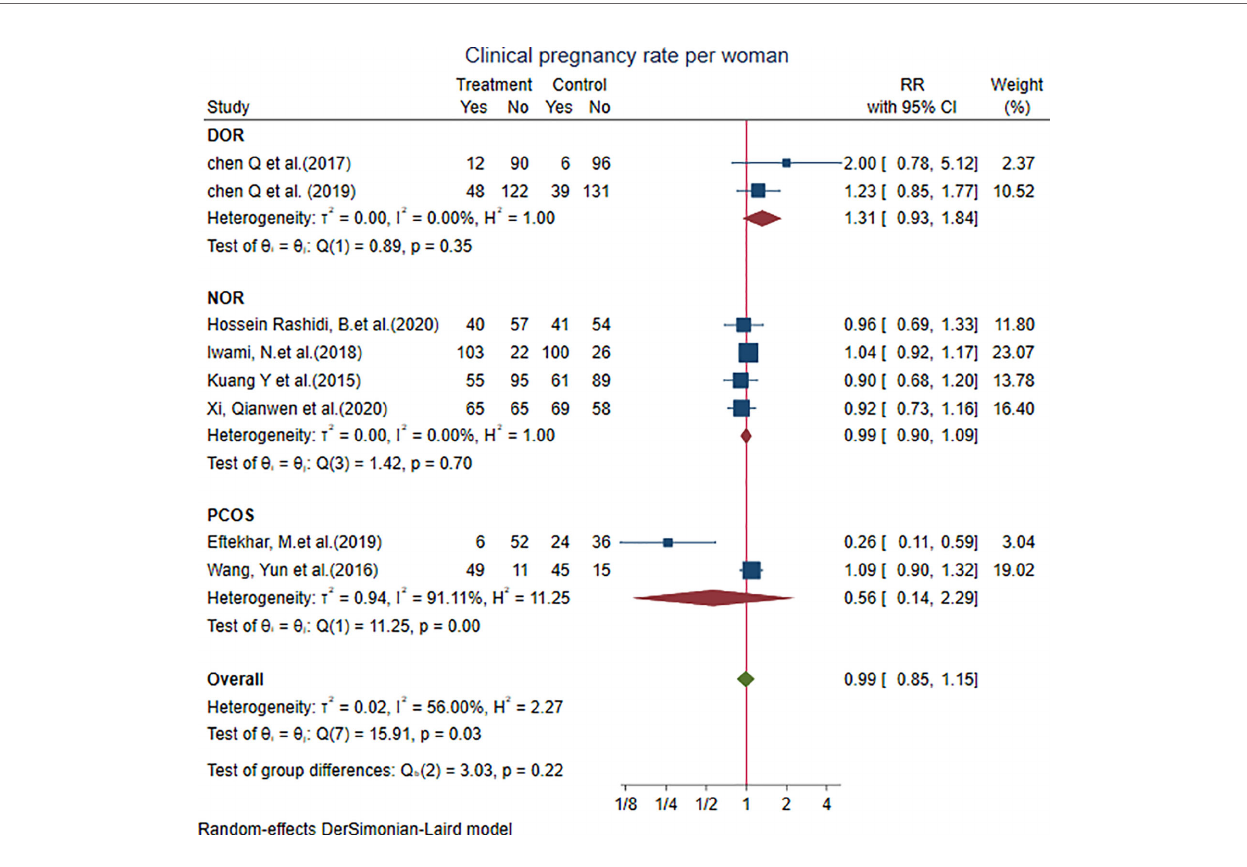
FIGURE 4 | Forest plot of studies of clinical pregnancy rate per